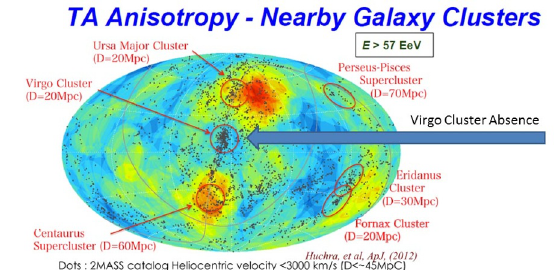
Figure 1: The combined map, in equatorial coordinates, based on the Auger and TA data. Note in red two Hot Spot UHECR clustering signals. The highest UHECR density event rates are north around M82 AGN for TA and south around Cen-A for Auger. The dark dots circled in red in the center [7] correspond to the closest potential sources included in the GZK volume, pointing to the Virgo